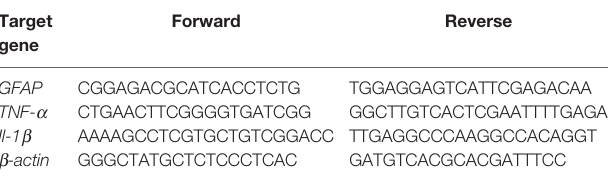
TABLE 1 | List of primer pairs for real-time